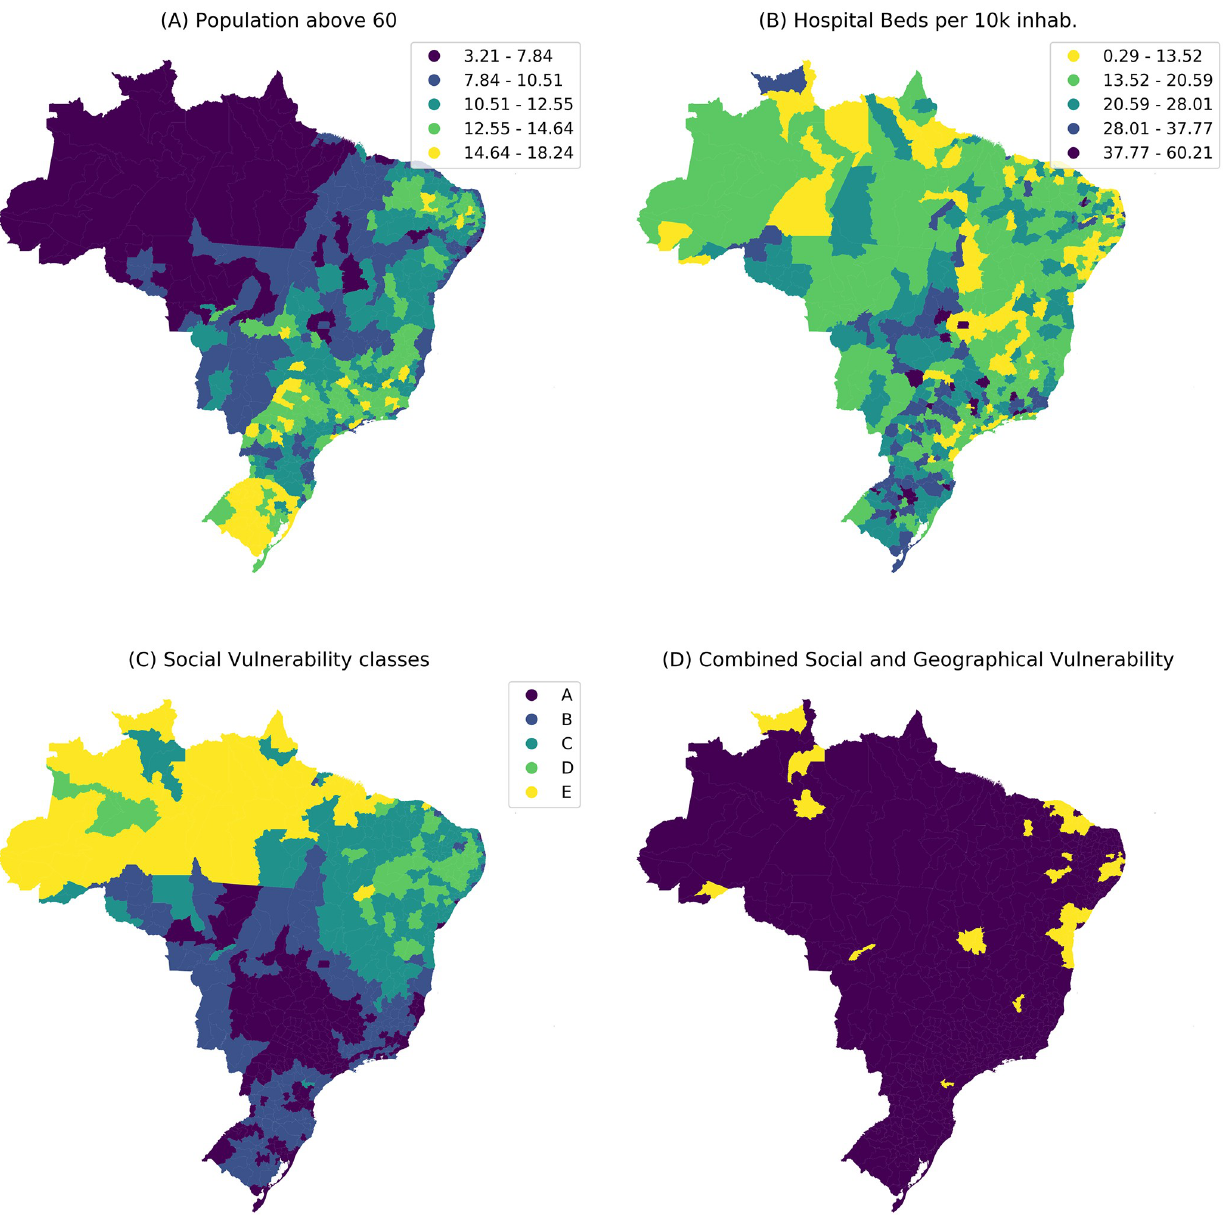
Fig 2. Vulnerability panel. (Top left) Percentage of population above 60 years old (Top right) Hospital capacity as number of hospital beds per 10 per 10,000 individuals; (Bottom left) classification of homogeneous areas in terms of socio-economic vulnerability. D and E are the most vulnerable; (Bottom Right) selection of micro-regions with high probability of imminent COVID-19 epidemics and high social